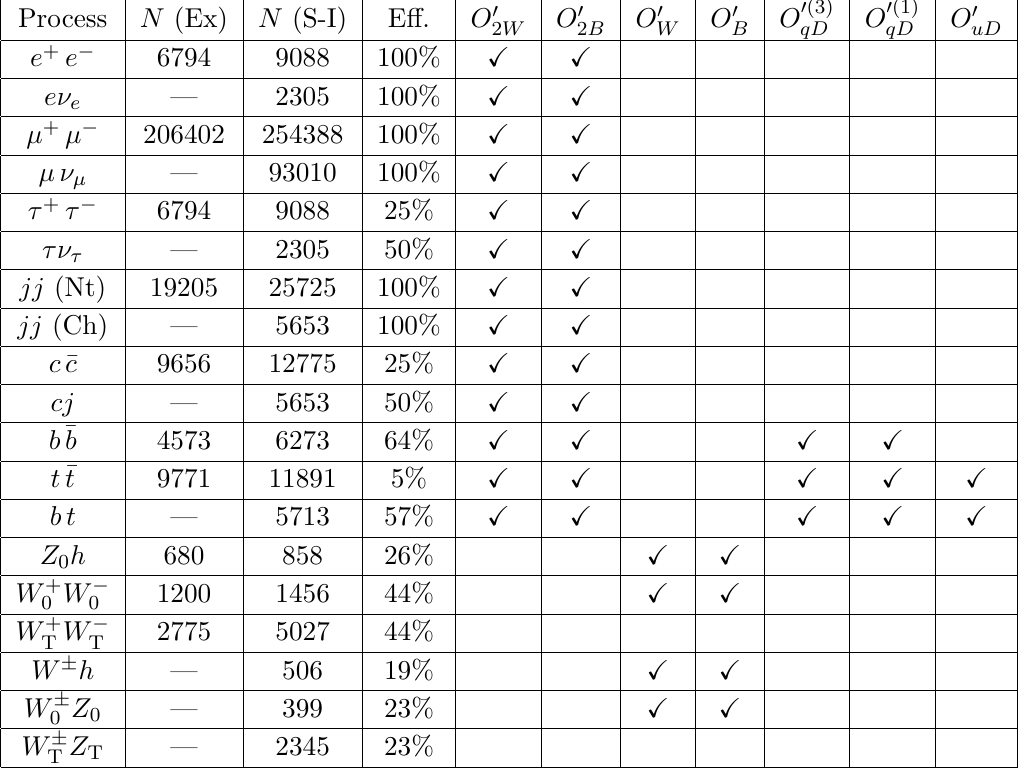
Table 3. The exclusive and semi-inclusive processes employed for the sensitivity projections. The operators that give a growing-with-energy contribution to each operator are labeled with a check mark. The expected number of events (before efficiencies) is for E luminosity